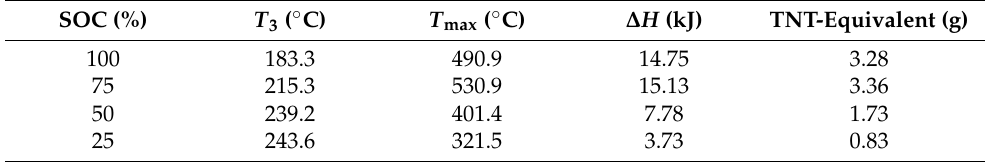
Table 3. The values of the energy and TNT-equivalent for the battery at different SOC conditions. SOC (%) T 3 ( ◦ C) T max ( ◦ C) ∆ H (kJ) TNT-Equivalent (g) 100